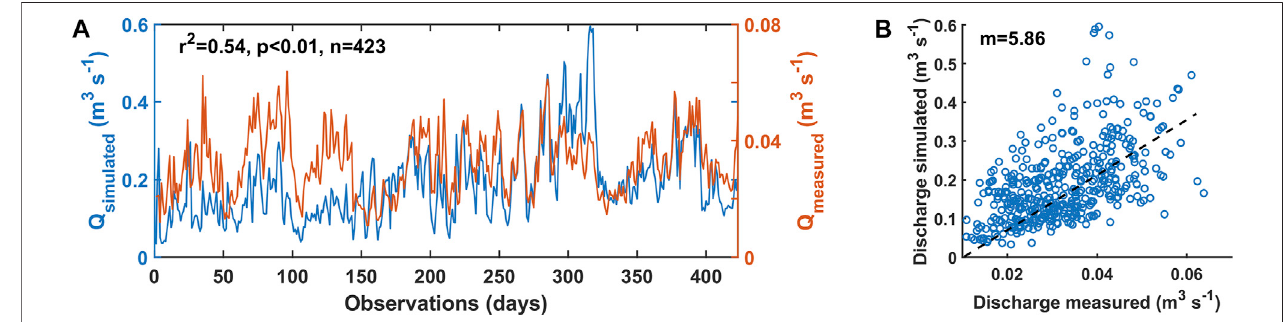
FIGURE 8 | (A) Comparison between simulated (blue line) and measured discharge (orange line). Only days with precipitation and discharge available are presented. (B) Scatterplotofmeasuredvs.simulateddischargedailyvalues.Dashedlinerepresentsthemeanratio(m=5.86)betweensimulatedandmeasuredvalues.